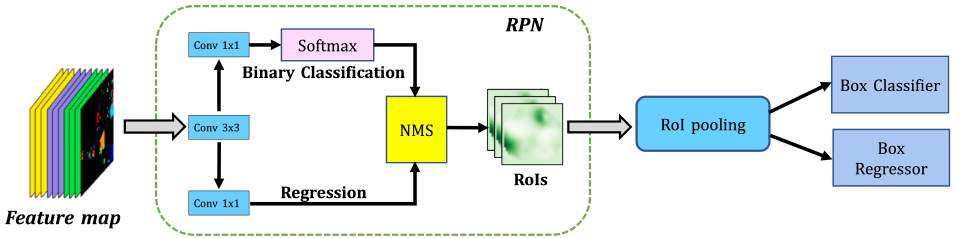
Figure 3. The diagram of the relaxed region proposal network module.